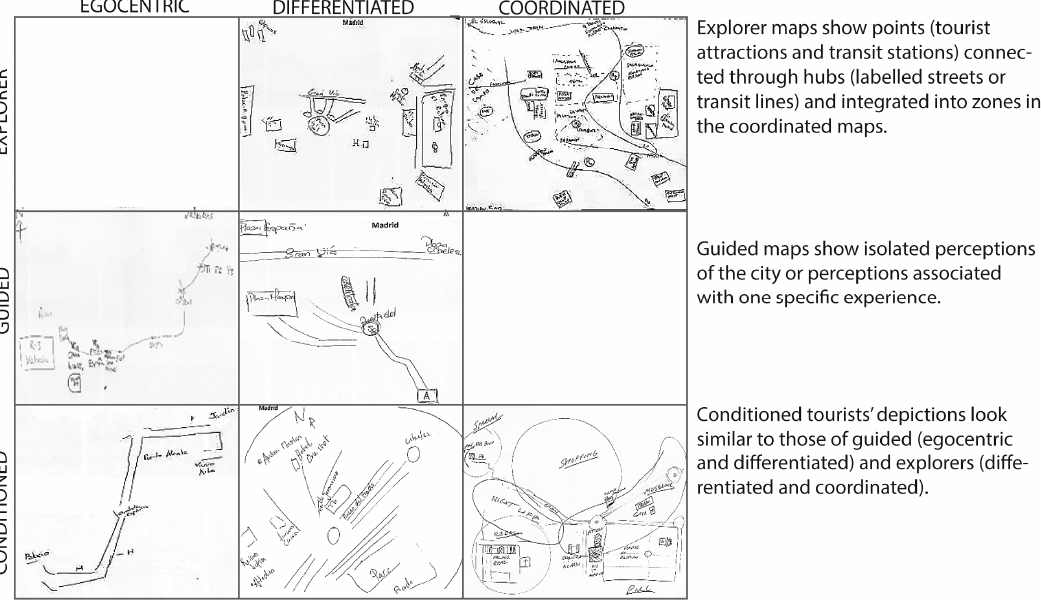
Figure 10. Evolution of sketches of an Explorer tourist throughout the stay (T5 in Figure 4). The number of features is shown to increase, while the coordinated reference system stays the same.